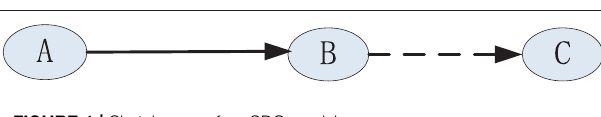
FIGURE 1 | Sketch map of an SDG